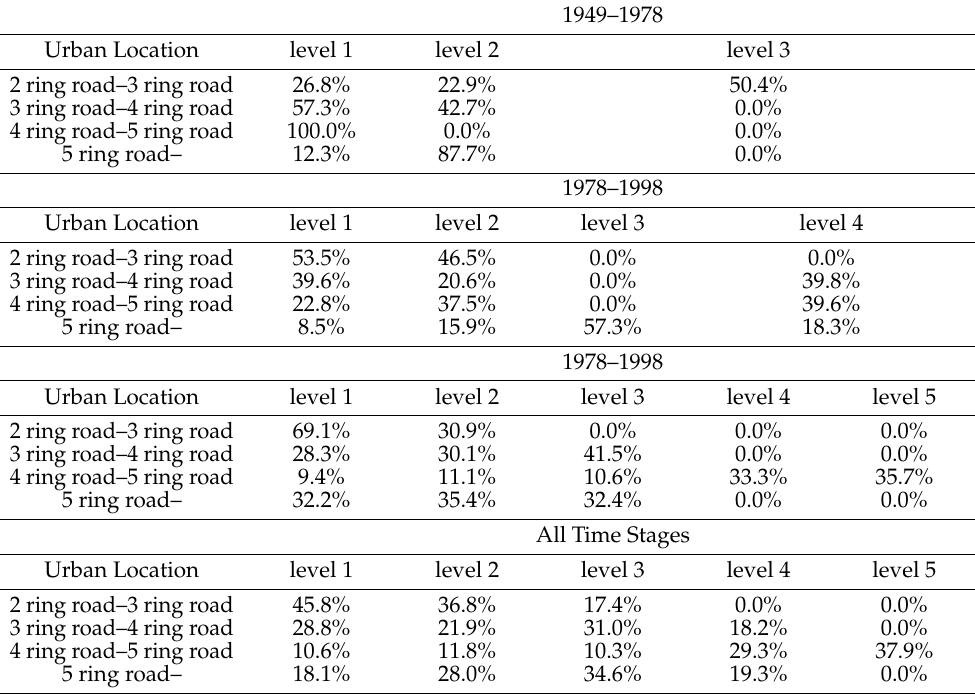
Table 3. Specific measurement results of the 2SFCA